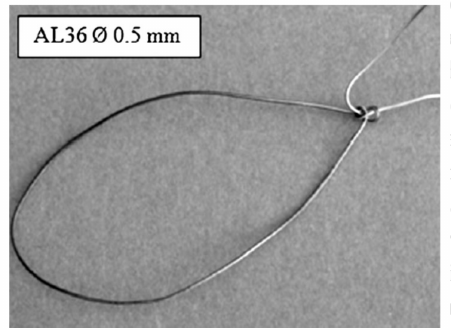
Figure 9. Knotted noose made of the alloy AL36, reproduced with permission from [125], WILEY,